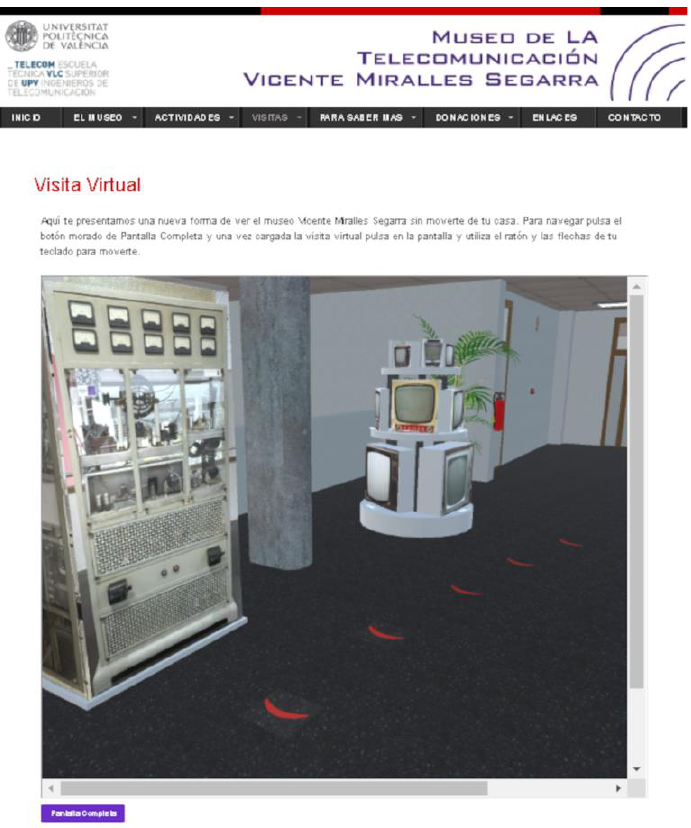
Figure 6. WebGL VR museum